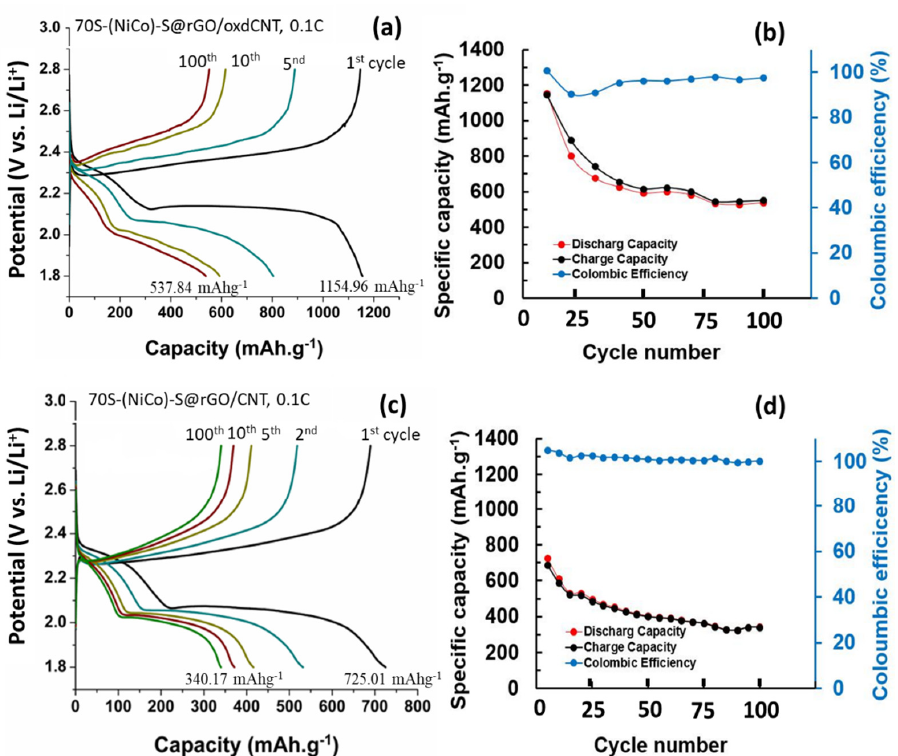
Figure 10. ( a , b ) charge/discharge curves, cycle performance and Coulombic efficiency of (NiCo)– S@rGO/oxdCNT/S. ( c , d ) Charge/discharge curves and Coulombic of nonacid treated CNT ((NiCo)– S@rGO/oxdCNT/S) at the current density of 0.1 C at 1st, 2nd, 5th, 10th and 100th cycles.